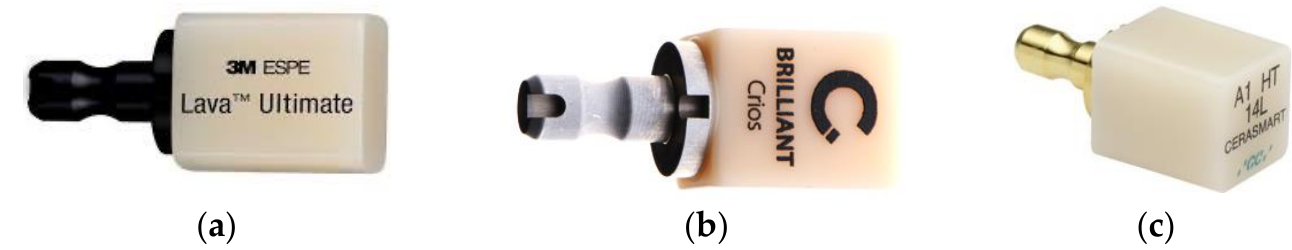
Figure 1. Chairside assistant computer-aid design and manufacturing technologies (CAD/CAM) C14 blocks: ( a ) Lava TM Ultimate Restorative (LU), ( b ) Brilliant Crios (BC), ( c ) Cerasmart TM (CS).